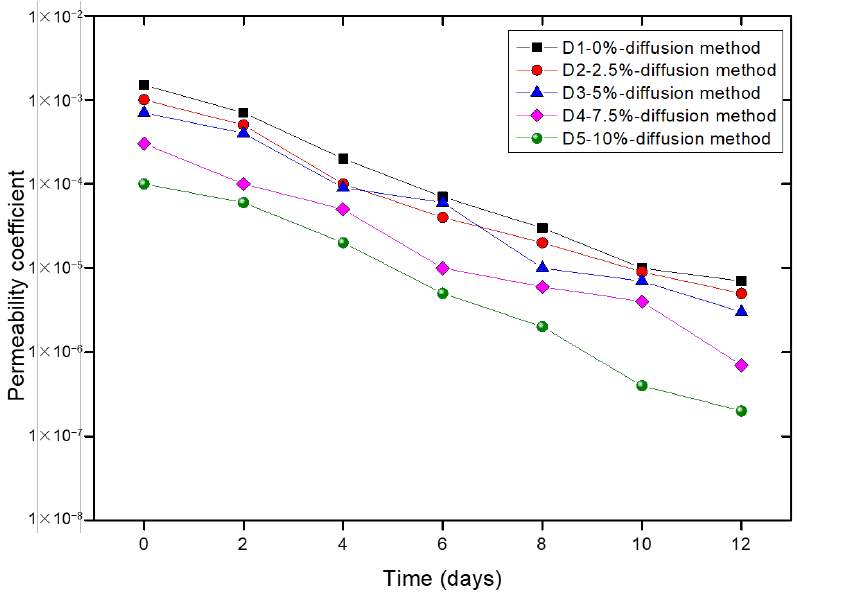
Figure 3. Change in the permeability of treated samples.